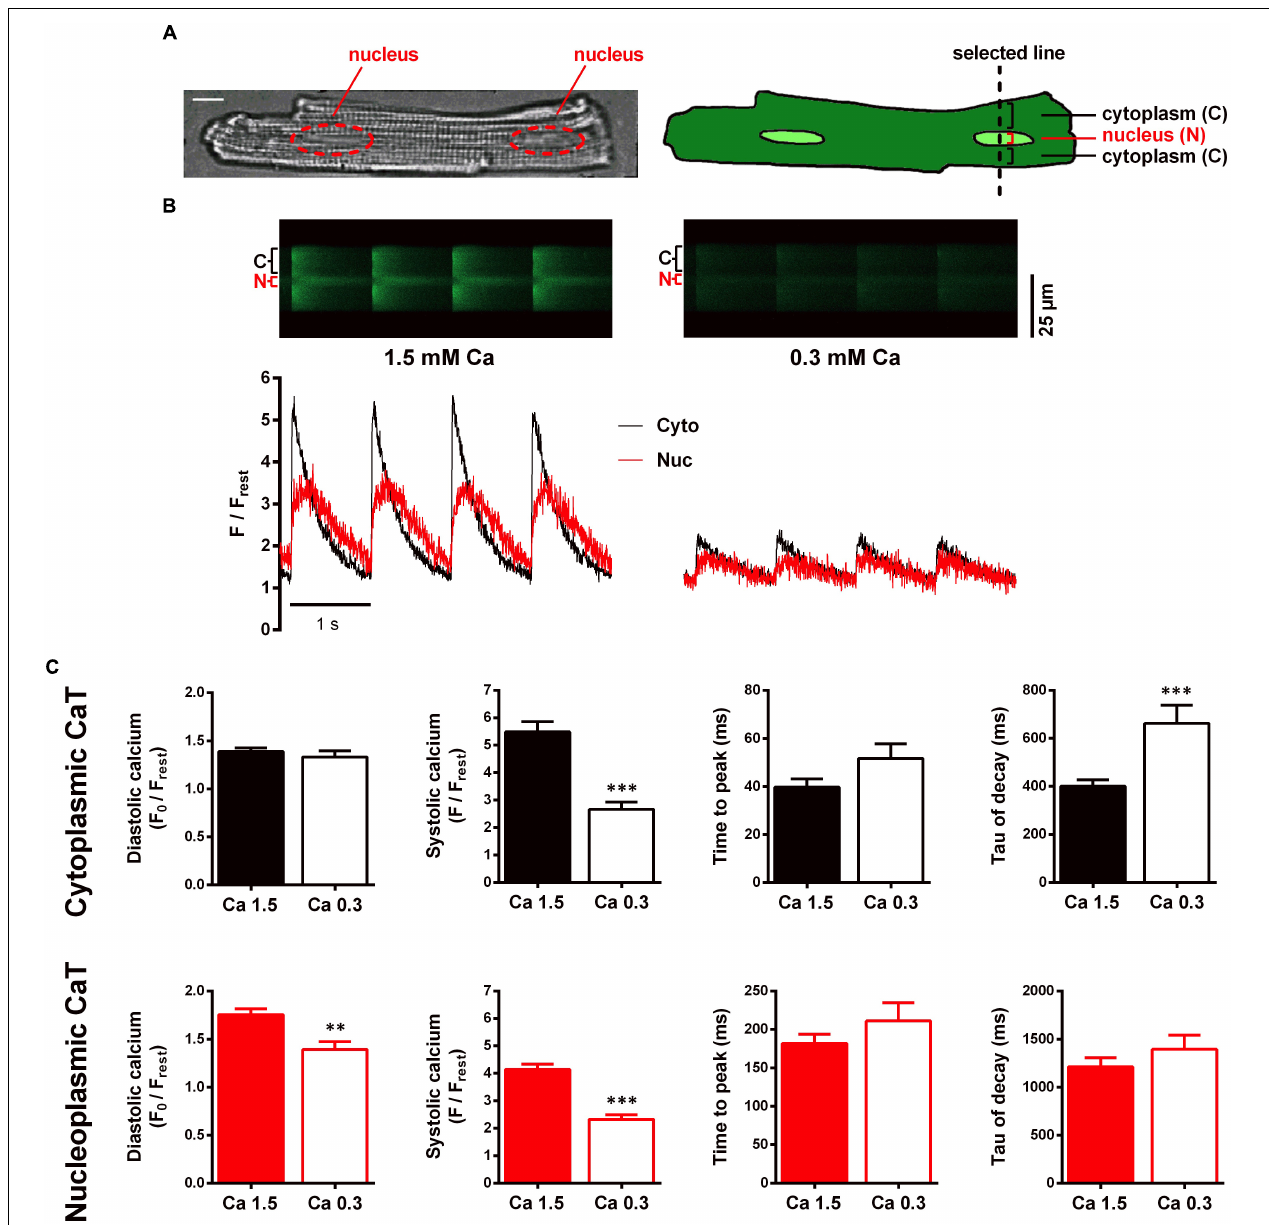
FIGURE 1 | Characterisation of electrically stimulated cytoplasmic and nucleoplasmic CaTs in WKY ventricular myocytes at 1.5 and 0.3 mM extracellular Ca concentration. (A) Microscopic image of a ventricular myocyte with two nuclei highlighted in red; white scale bar represents 10 µ m (left). Schematic drawing of a myocyte illustrating the scan line setting and the scanned regions (right). (B) Different myocyte. Left panel: original line-scan recording, showing electrically evoked cytoplasmic (C, Cyto, black) and nucleoplasmic (N, Nuc, red) CaTs at 1.5 mM extracellular [Ca] and the corresponding normalized fluorescence trace. Right panel: line-scan fluorescence image and corresponding trace of CaTs at 0.3 mM extracellular [Ca]. (C) Mean values of cytoplasmic and nucleoplasmic CaT parameters: diastolic Ca (F 0 /F rest ), systolic Ca (F/F rest ), time to peak and tau of decay. ∗∗ P < 0.01, ∗∗∗ P < 0.001, n / N = 19/7.